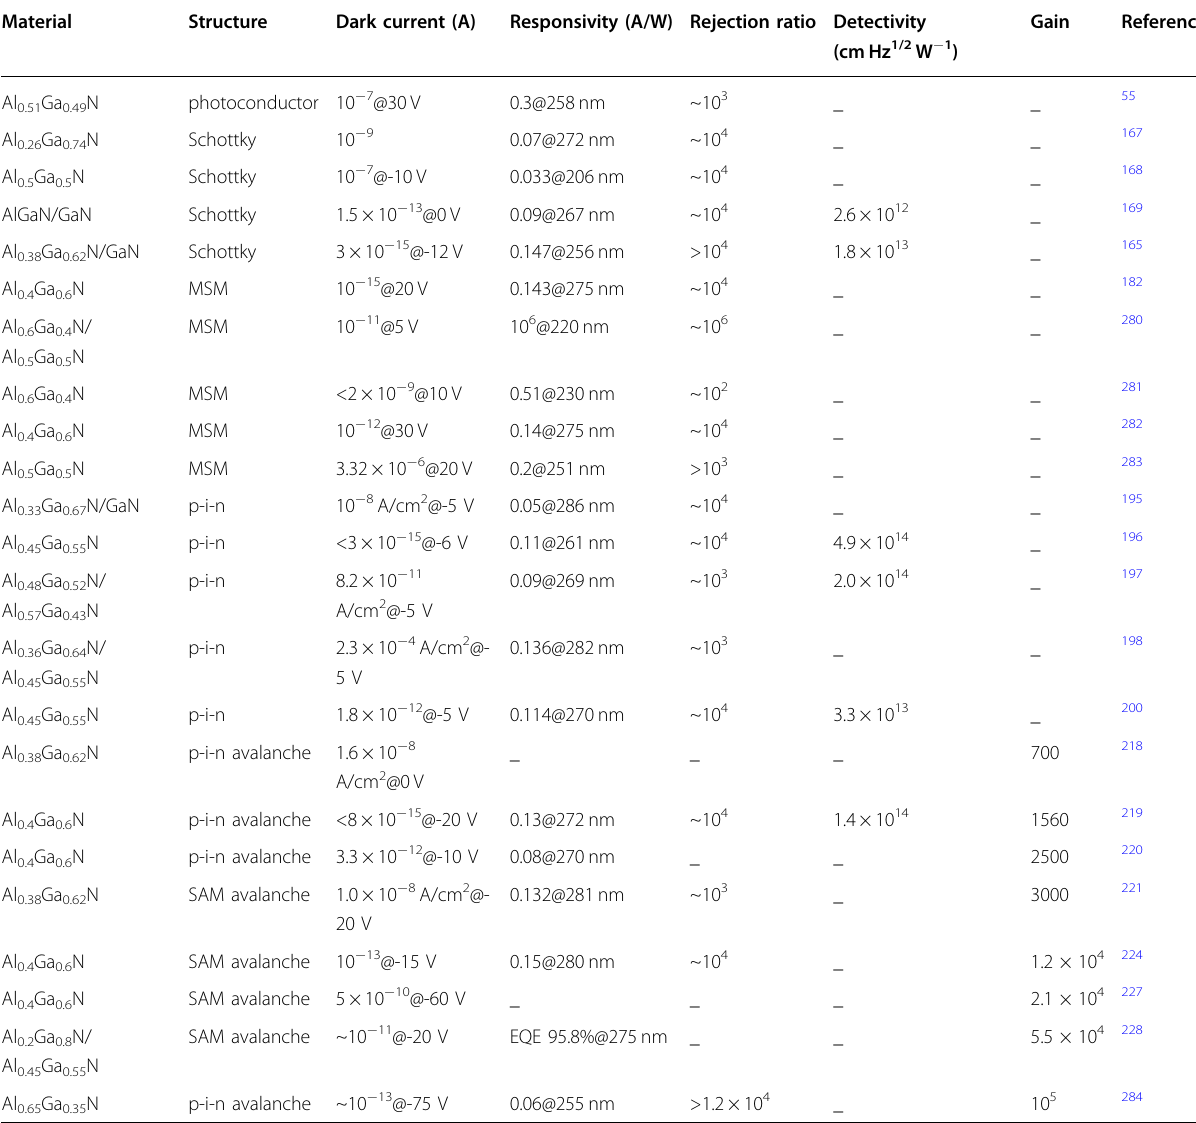
Table 3 Summary of the reported parameters of various AlGaN-based solar-blind photodetectors